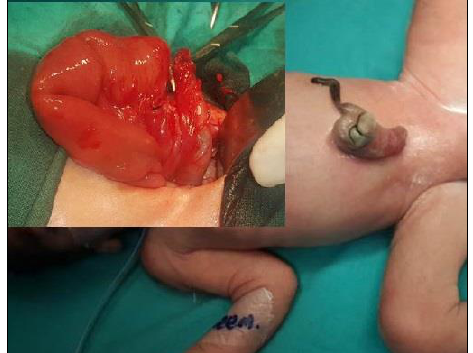
Figure 13: HUC with evisceration of bowel mass from umbilical cord. Inset shows rest over few inches of proximal jejunum and distal sigmoid colon. The rest of entire gut has been lost in a presumable in-utero volvulus of the eviscerated bowel from the umbilical cord. [Courtesy of Dr. Nabi Bux, Dept. of Pediatric Surgery, The Children’s Hospital and the Institute of Child Health, Lahore]